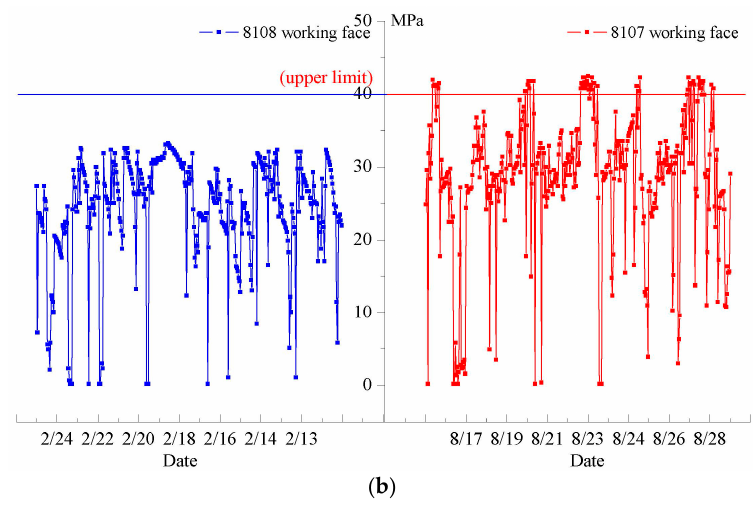
Figure 11. Weighing-characteristic curves for 8107 and 8108 working faces; ( a ) distribution of supports resistance; ( b ) periodic weighting characteristic.